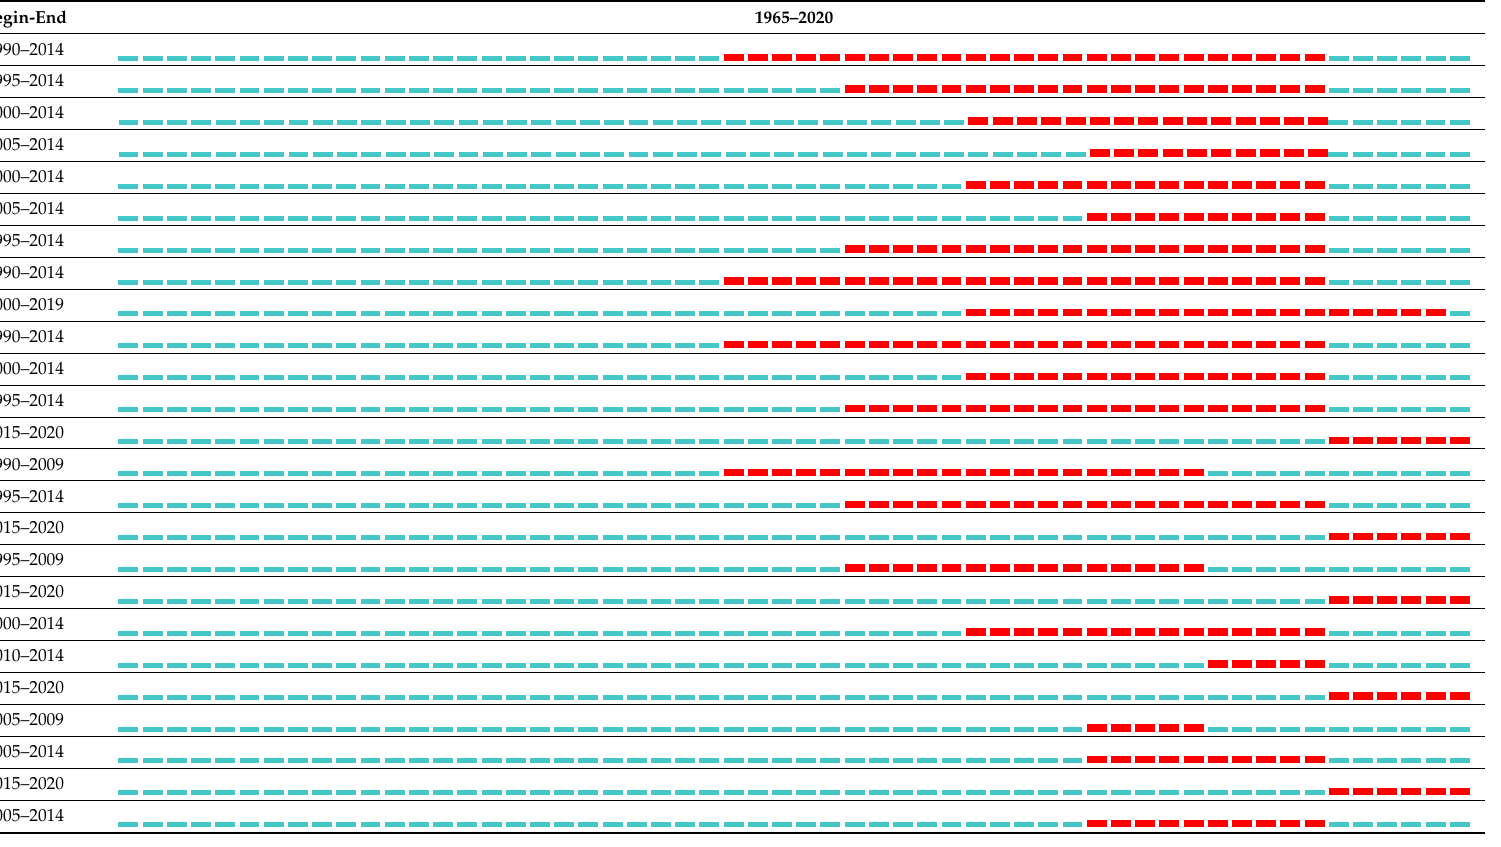
Table 5. Top 25 keywords with the strongest citation